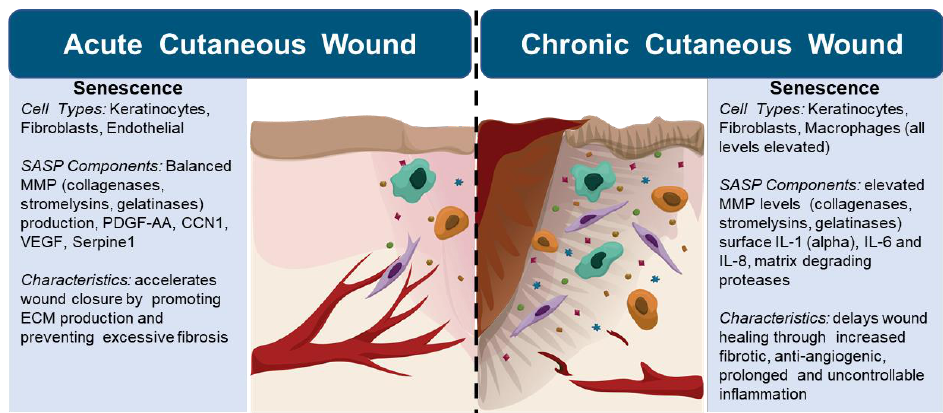
Figure 4. Senescent cells in acute and chronic cutaneous wounds [45]. Senescent cells vary by type, distribution, SASP production, and elicit varying phenotypes depending on wound chronicity [42,46,52 – 55] . Cellular senescence may participate in physiologic healing in acute contexts while inhibiting overall wound closure in a chronic setting [42,50 – 52,54,56 – 59] .